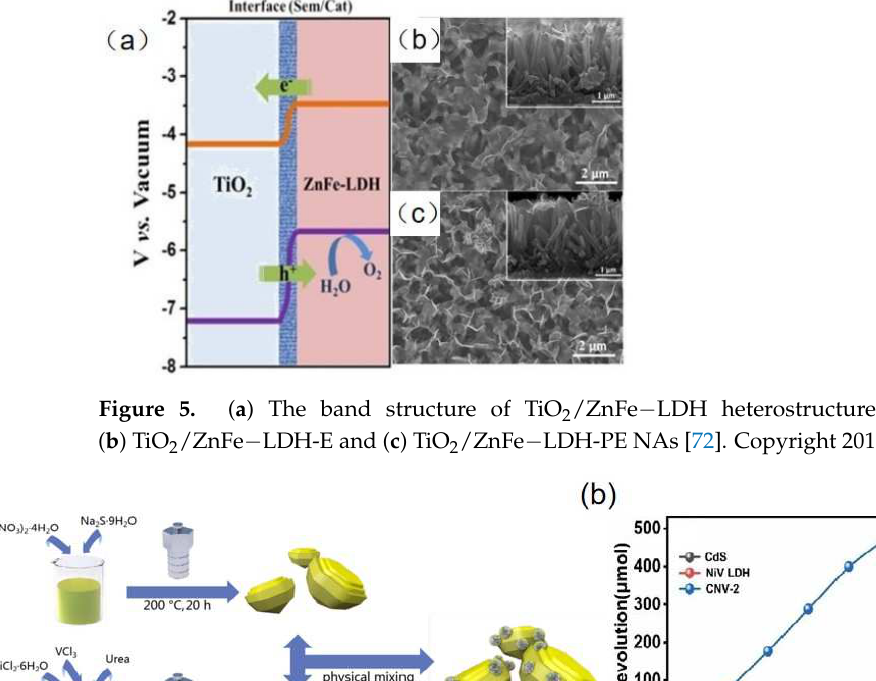
conversion of optimized Co(OH) 2 -modified ZnCr LDH sample reached 13.12% and 6.25% in 2 h, respectively.